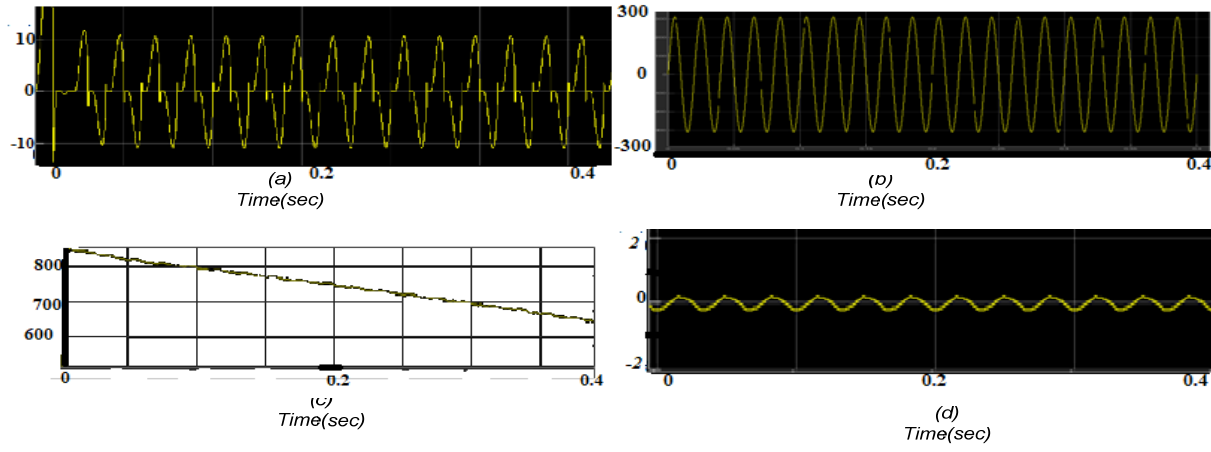
Figure 9. Case 1 LSTM-based system signals. ( a ) Source current (A); ( b ) source voltage (V); ( c ) DC voltage (V); ( d ) neutral wire current (A).